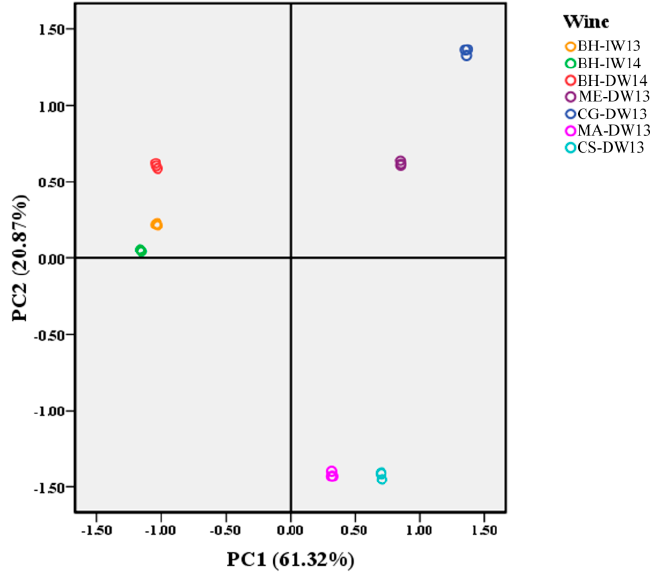
Figure 6. PCA analysis of phenolic compounds in different wine products.